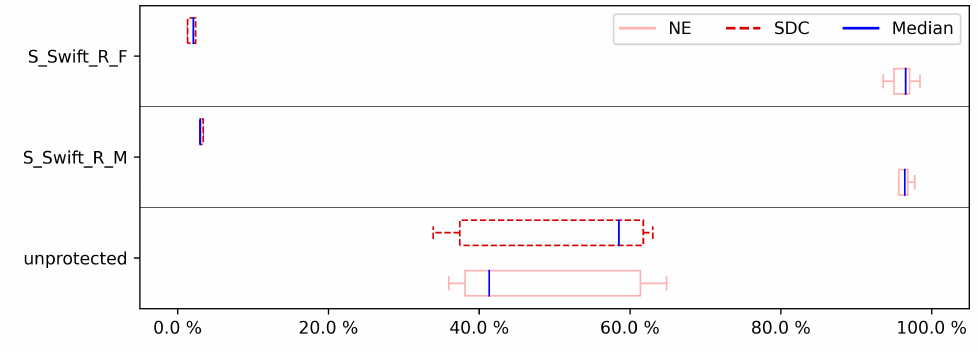
Figure 10. DFE fault injection results for 4 registers.